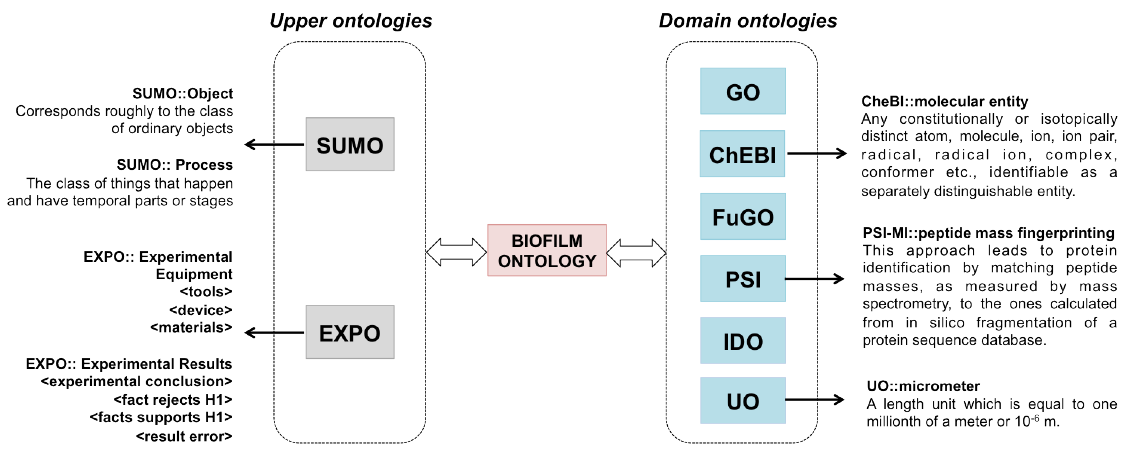
Figure 3: The interoperation of the Biofilms ontology with domain ontologies (at the right) and upper ontologies (at the left) and some examples of terms reused. GO – Gene Ontology; ChEBI – Chemical Entities of Biological Interest; FuGO – Functional Genomics Ontology; PSI – Protein Standards Initiative; IDO – Infection and Disease Ontology; UO – Units of measurement Ontol- ogy; SUMO – Suggested Upper Merged Ontology; EXPO – Experiment